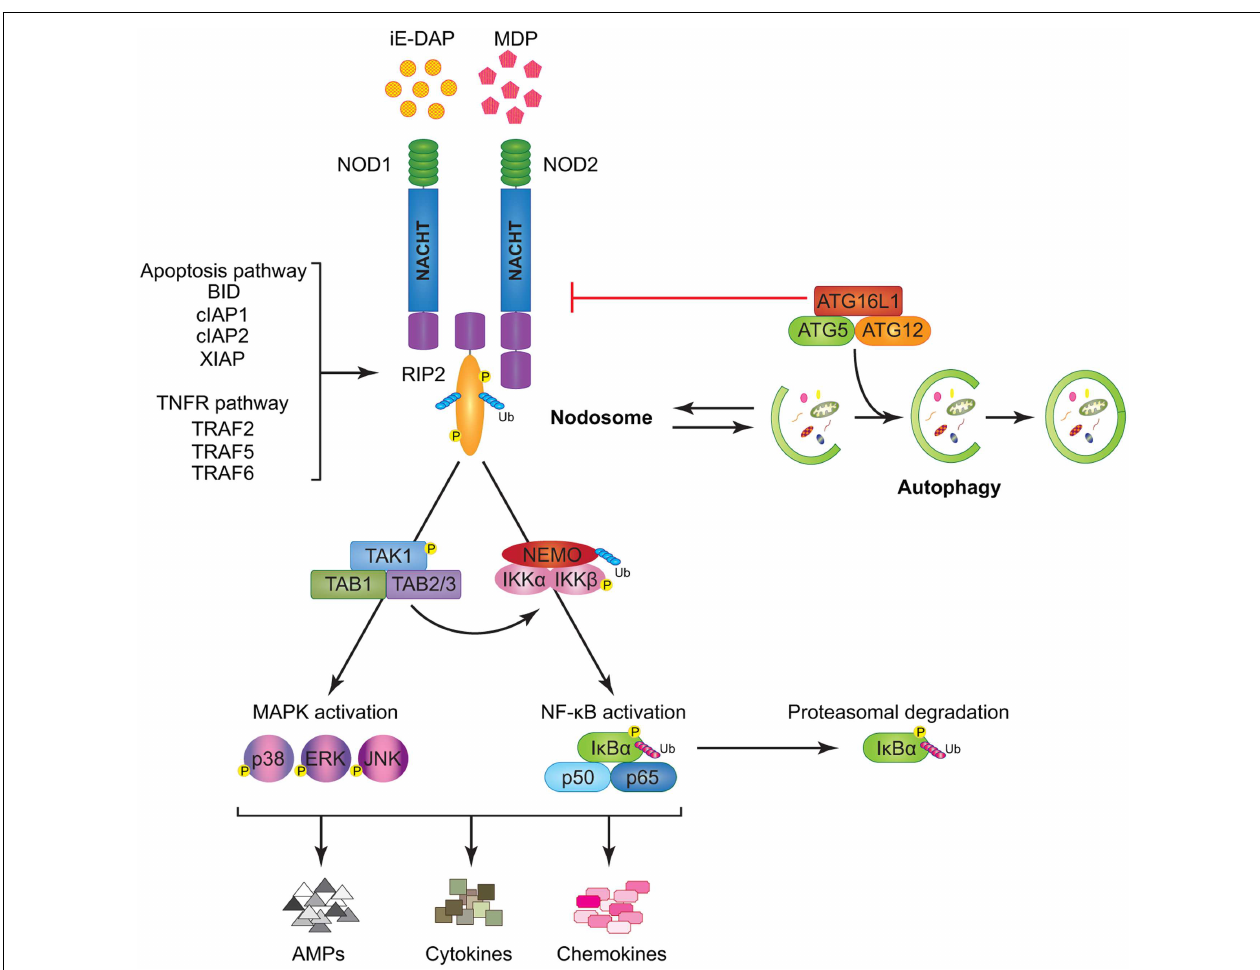
proteasomal degradation, and by freeing p50 and p65 NF- κ B subunits. On the other hand,TAK1 recruitsTAB1 andTAB2/3 inducing both (p38, ERK, and JNK) MAPK and NF- κ B activation. Stimulation of both arms culminates in the induction of anti-microbial peptides (AMPs), cytokines, and chemokines.The formation of the Nodosome promotes autophagy and conversely, a fully functional autophagy machinery helps in signal transduction through the Nodosome. ATG16L1 along with ATG5 and ATG12 is required for autophagosome formation, however, independently of its autophagy functions, ATG16L1 negatively regulates NOD/RIP2